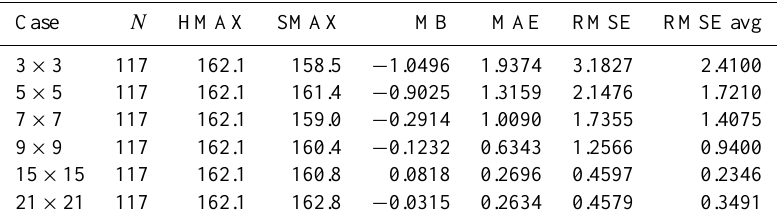
Table 5. Statistical parameters of simulations with different STOPS domain sizes. In each case, only nine inner cells were taken for the analysis. The results correspond to the stationary